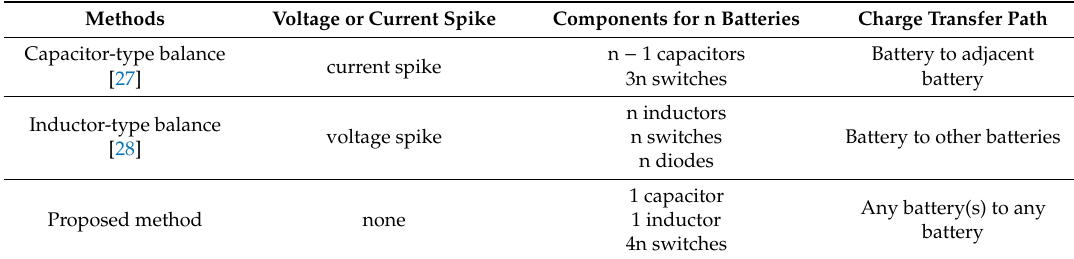
Table 6. Comparison with existing methods.